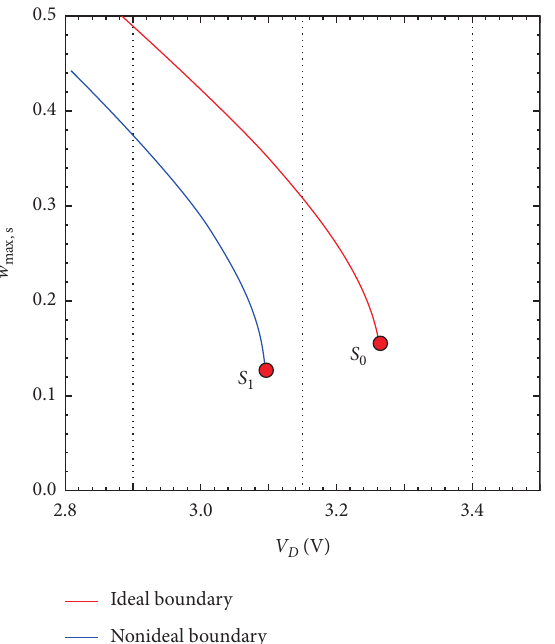
Figure 9: Maximum deflection at the time of the transition-DC voltage